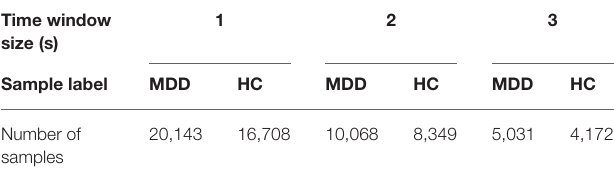
TABLE 2 | Basic information on the